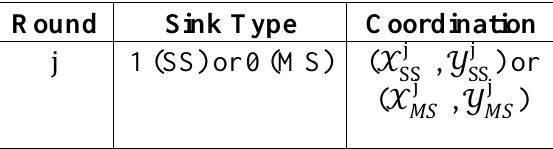
Table 1. Hello message (for both SS and